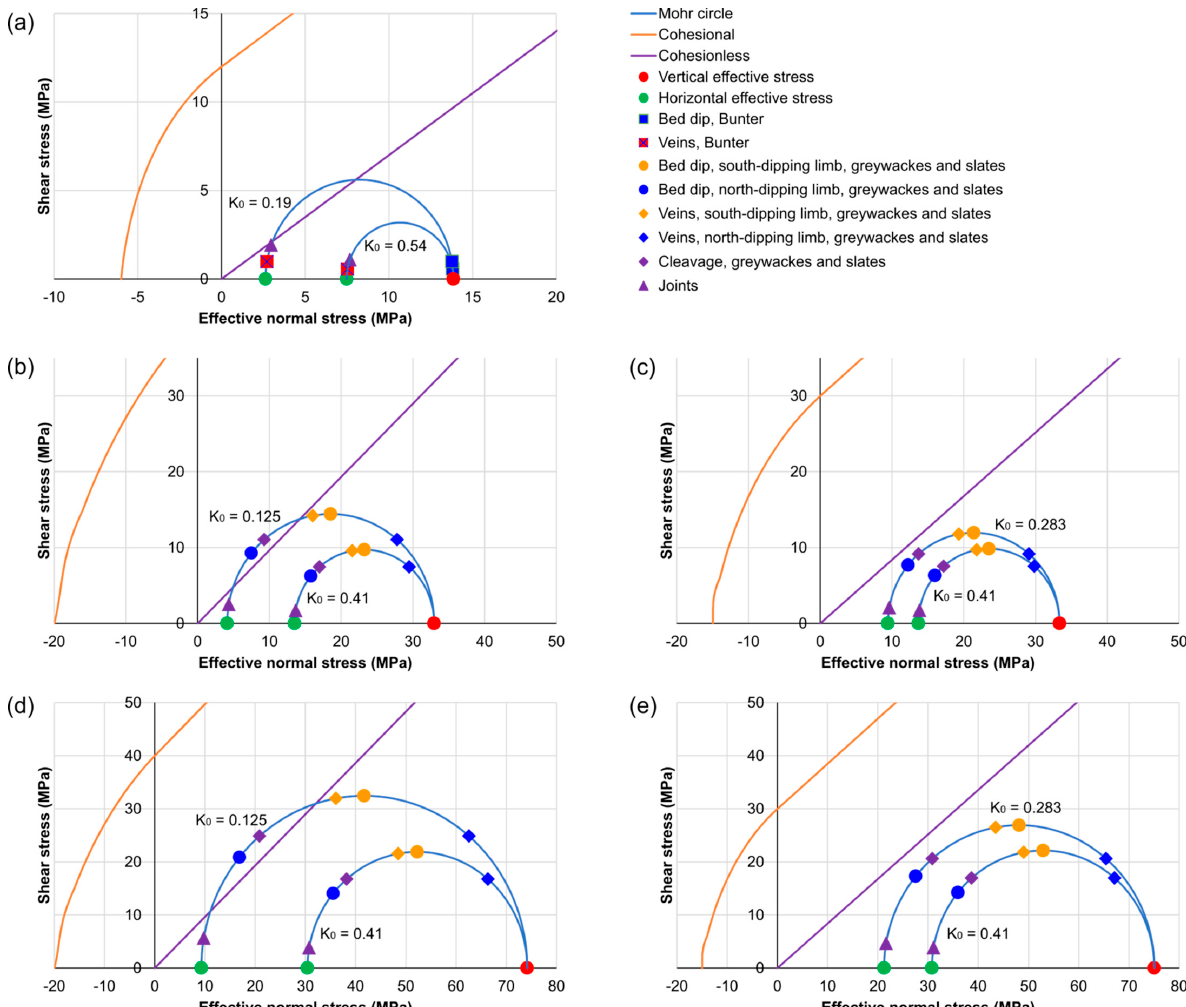
Figure 2. Base case Mohr diagrams, with Mohr circles for end-member geostatic stress ratios (k 0 ) shown (see Table 3 for parameters used). Representative dips of structures are shown to illustrate which of these structures might be reactivated under different stress conditions. ( a ) The Bunter Sandstone. ( b ) Devonian and Carboniferous greywackes at a depth of 2 km. ( c ) Devonian and Carboniferous slates at a depth of 2 km. ( d ) Devonian and Carboniferous greywackes at a depth of 4.5 km. ( e ) Devonian and Carboniferous slates at a depth of 4.5